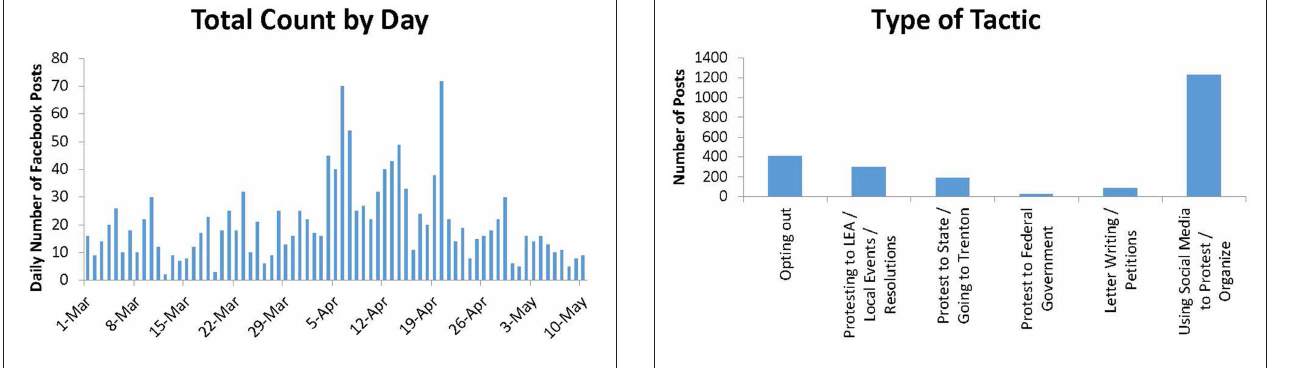
FIGURE 1 | Daily number of Facebook posts, spring 2016. FIGURE 2 | Types of protest